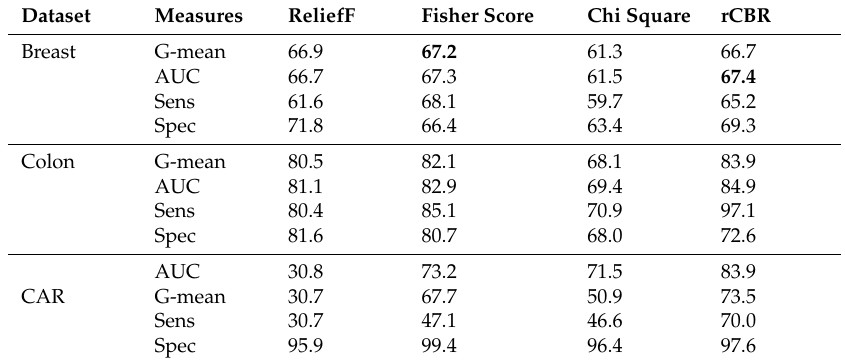
Table 3. Comparison of the proposed rCBR method against single filter-based methods in terms of G-mean, AUC, Sensitivity (Sens) and specificity (Spec) performance